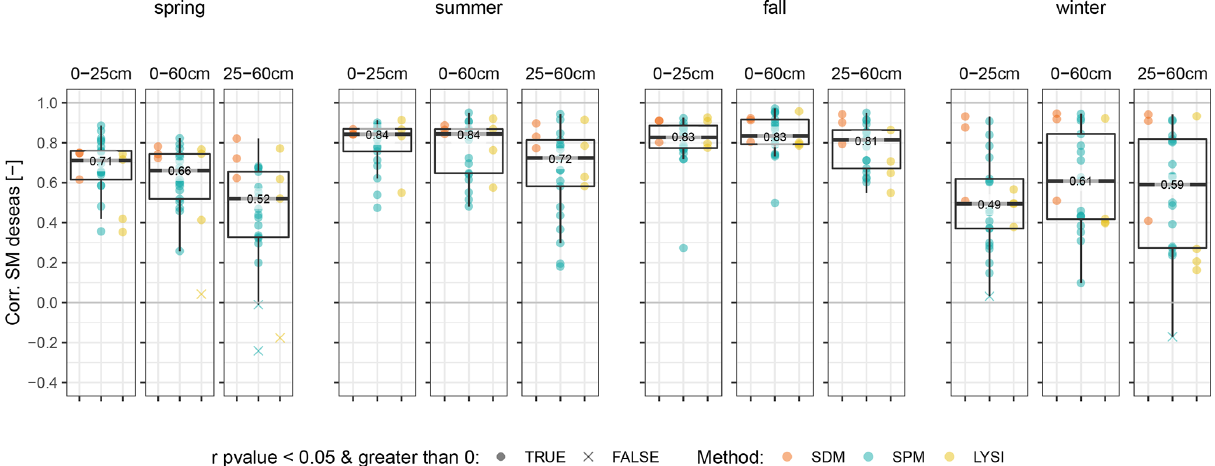
Figure 6. Spearman correlation coefficients of the simulated mHM SM in the GDM-v2-2021 against observed deseasonalized SM anomalies, depicted with boxplots for three depths (0–25, 0–60, 25–60cm). Values of each location are plotted, and colors denote the measurement method of the SM data (SDM: spatially distributed measurements; SPM: single profile measurements; LYSI: lysimeter). Here, only locations with measurements at 25–60cm depth are taken into account (SDM: n = 3, SPM: n = 19, LYSI: n = 4). Data points that are not both significantly ( p -value < 0.05) and positively correlated are marked with